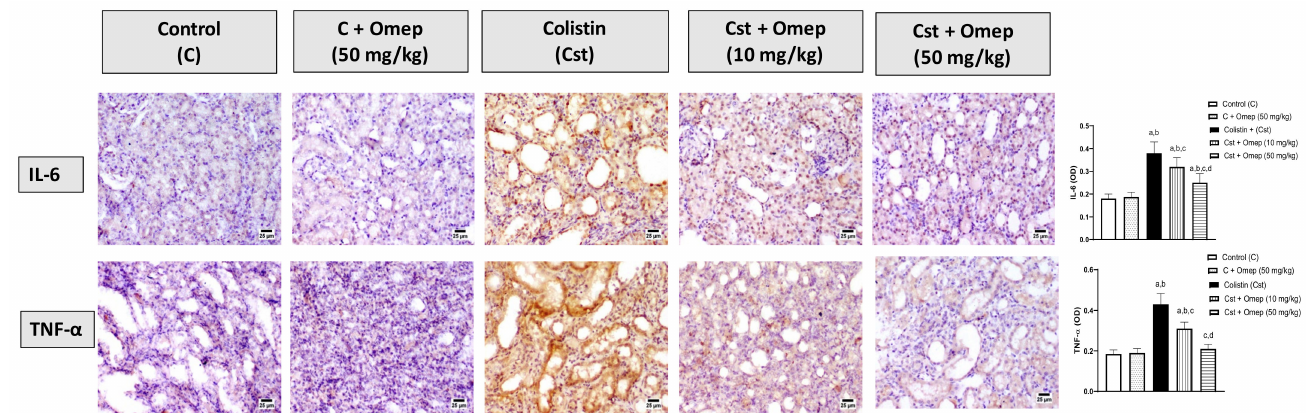
Figure 4. Effect of omeprazole on the expression of IL-6 and TNF- α . Immunohistochemical photomi- crographs of kidney sections showing the effect of omeprazole on colistin-induced alterations in IL-6 and TNF- α . Data shown in bar charts are the Mean of optical densities ± SD ( n = 6). Omeprazole = Omep; Colistin = Cst. a: Significantly different from Control at p < 0.05; b: Significantly different from Omep (50 mg/kg) at p < 0.05; c: Significantly different from Cst at p < 0.05; d: Significantly different from Cst + Omep (10 mg/kg) at p < 0.05.